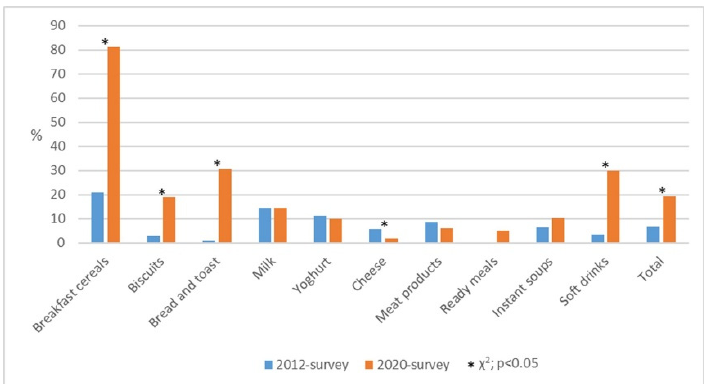
Figure 3. The proportion of pre-packaged food products containing nutrition claims in the 2012 survey [15] and the 2020 survey by product category. % is calculated over the total of products within each food group; * marks statistically significant difference between proportions in the 2012 survey and the 2020 survey, Chi-square test, p < 0.05.